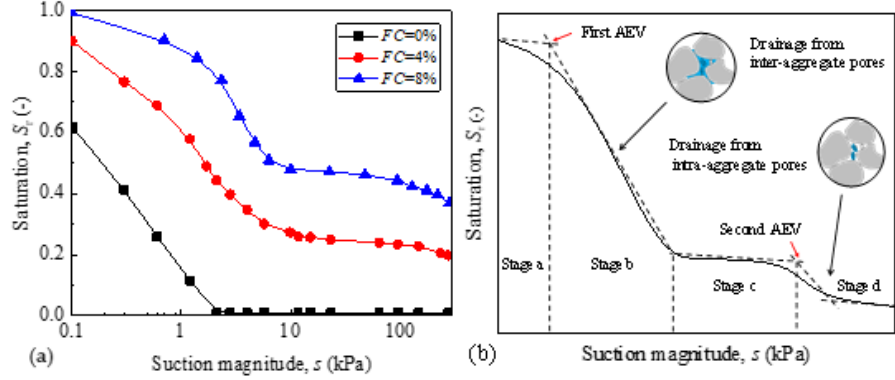
Figure 3. ( a ) The SWRCs at different fine contents; ( b ) physical model for bimodal SWRC.